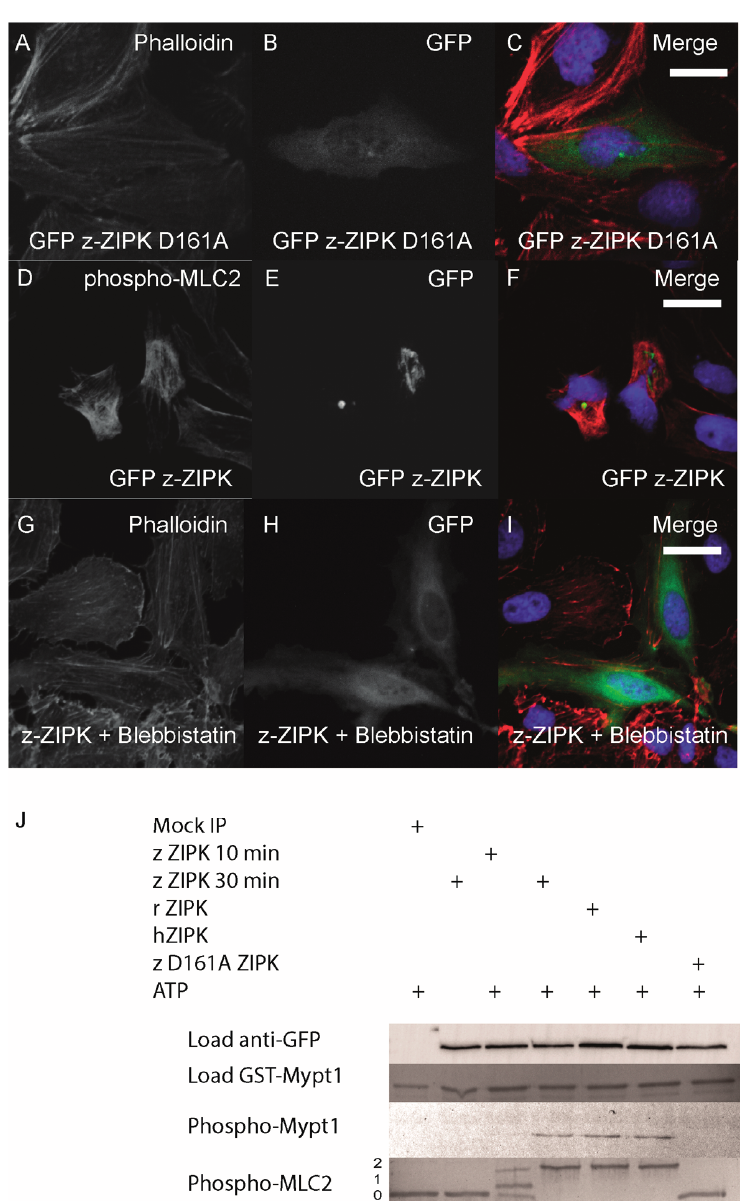
Figure 5. Zebrafish ZIPK controls the actin cytoskeleton by regulating type-II myosin (MLC2) phosphorylation. HeLa cells were transfected with a kinase dead D161A zebrafish GFP-ZIPK ( A , B , C ) and fixed and stained with DAPI and Alexa 568-phalloidin; HeLa cells were transfected with a zebrafish GFP-ZIPK ( D , E , F ) and immunostained using an anti-phospho myosin light chain 2 antibody, co-stained with DAPI; HeLa cells were treated with media containing either 0.1% DMSO (not shown) or 50 μ M blebbistatin ( G , H , I ) for 4 h; Black and white images show phalloidin staining, while color images are a merge of DAPI (blue), GFP (green), and phalloidin (red). ( J ) Zebrafish, Rat and Human ZIPK immunoprecipitated from HEK 293T cells were used to phosphorylate purified GST-Mypt1 and GST-MLC2. Unphosphoryled ( 0 ), mono ( 1 ) and di-phosphorylation ( 2 ) MLC2 was detected by band shift using a phos-tag SDS-PAGE gel and stained with Coomassie. Phosphorylation of Mypt1 was detected using a phospho-specific antibody (T696). Each experiment was replicated a minimum of three times. White bar indicates a 20 μ m scale